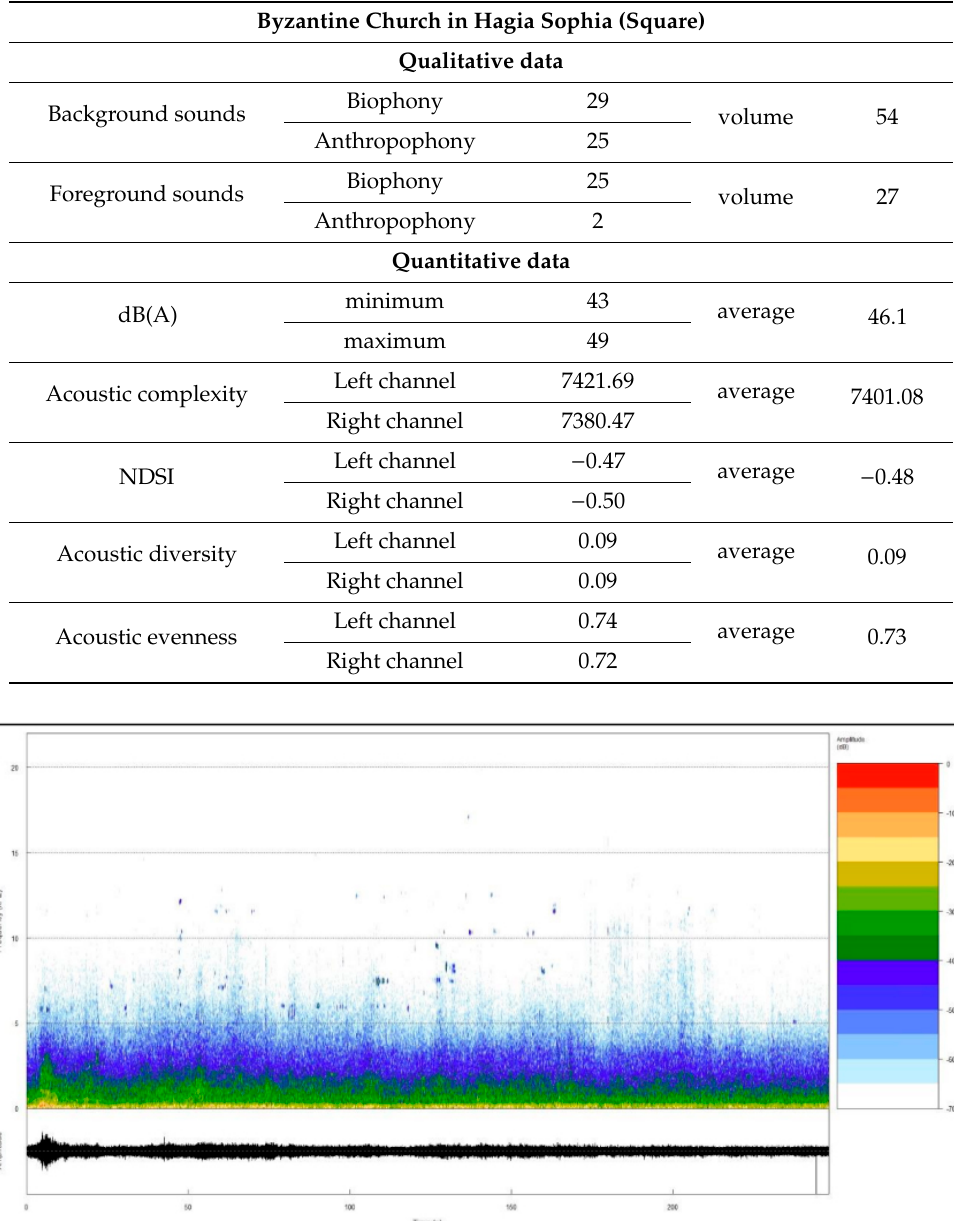
Table 4. The indicators resulted from the Hagia Sophia Square sound recordings. The negative sign in the NDSI highlighted the fact that anthropophonic sounds prevailed.